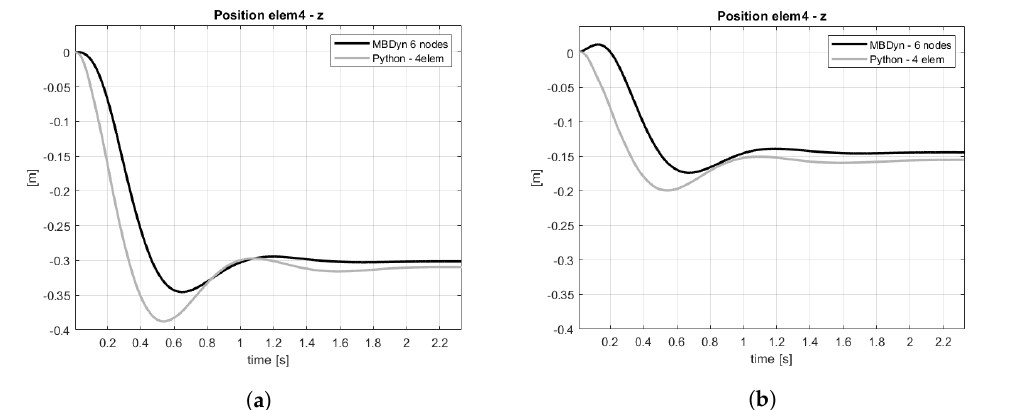
Figure 13. Comparison of vertical displacement at elem4 position ( a ) without and (b ) with aerodynamics. The model is in rotation and under